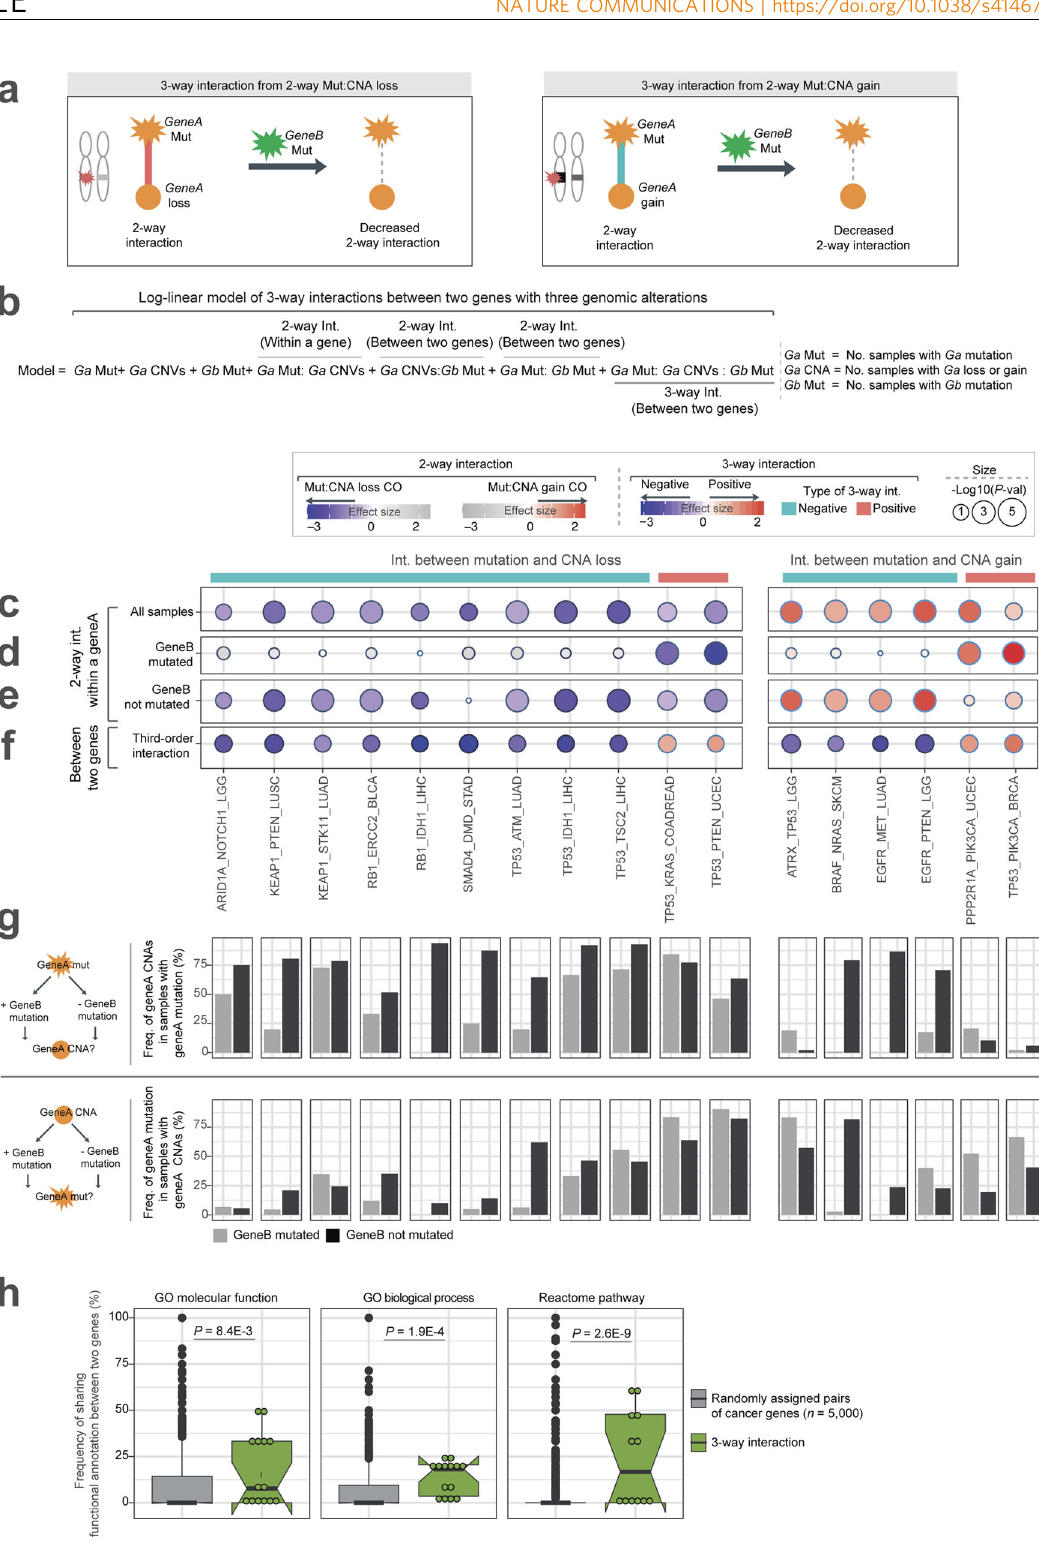
truncation mutations (encompassing splicing variants, frameshift indels, and nonsense variants) and to non-synonymous (missense mutation), single-residue substitutions (in-frame indels). Predicted deleterious missense was assigned at least one of two tools (SIFT and PolyPhen2) predicted as deleterious/damaging variant 32,33 . Genomic regions with signi fi cant levels of CN arrangements and their target genes of these somatic CNAs were determined using GISTIC 2.0 with their q -values 34 . Gene-level CN data were obtained from Synapse (syn5049520). High- level deletion for a gene was de fi ned as GISTIC threshold CN value of − 2, whereas high-level ampli fi cation for a gene was assigned with threshold CN value +